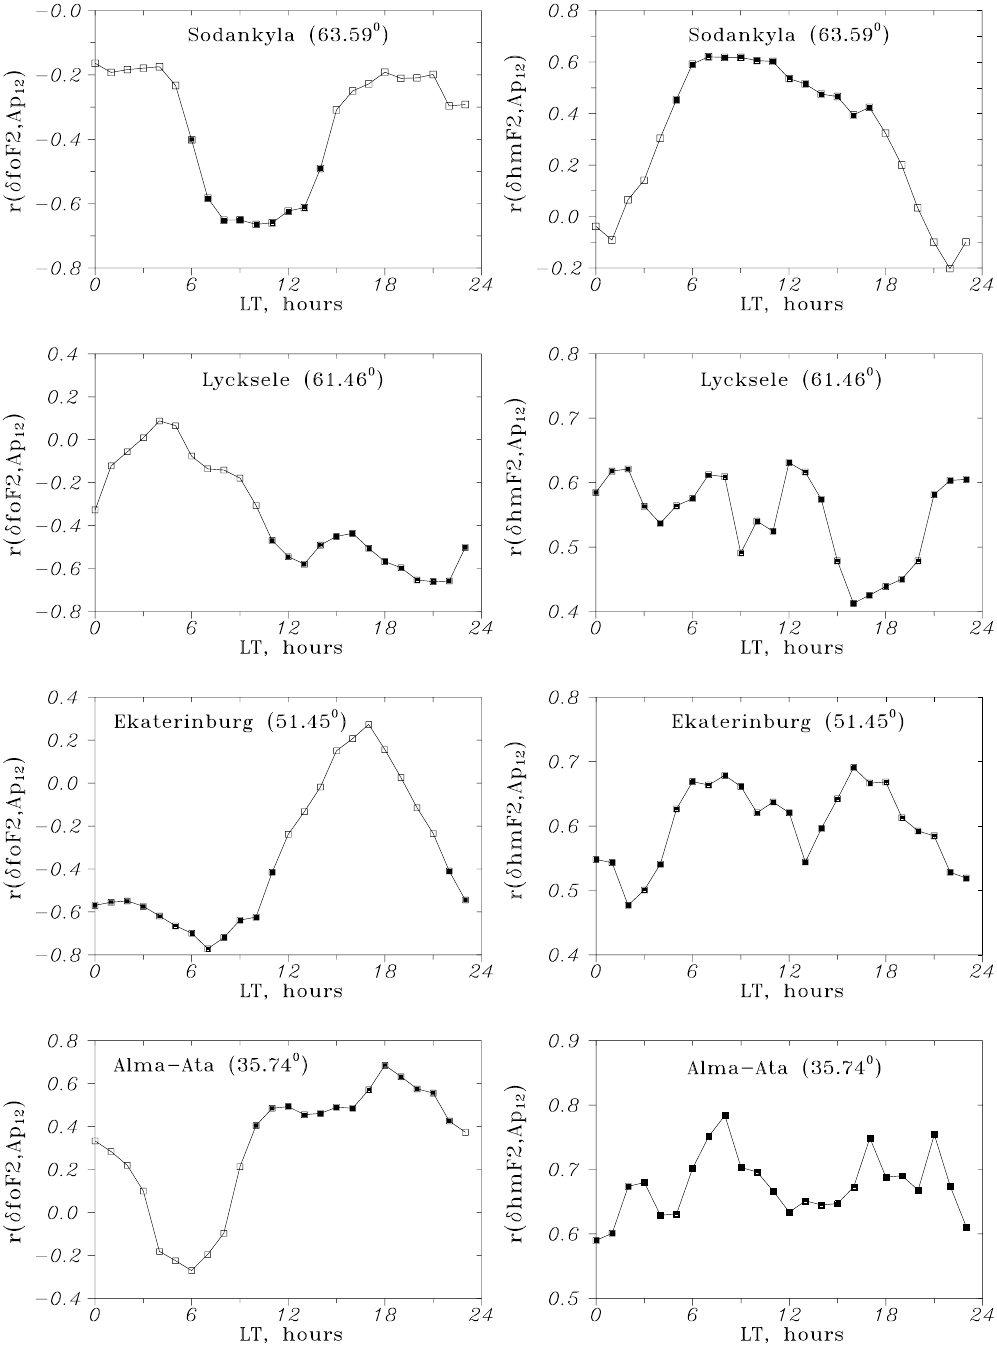
Fig. 2. Same as Fig. 1, but for correlation coefficients r(δ fo F2, Ap 12 ) and r(δ hm F2, Ap 12 ) . Solid squares are correlation coefficients significant at the 95% confidence level, open squares – the coefficients which are insignificant at this